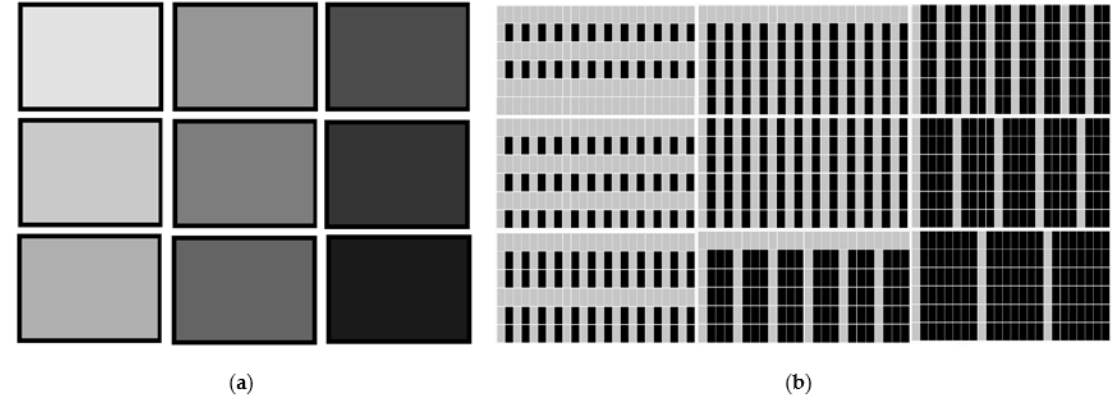
Figure 1. Semitransparent PV experimental matrices from 10% to 90% transparency in 10% increments for: ( a ) thin film PV; ( b ) crystalline silicon-based PV cell separation.